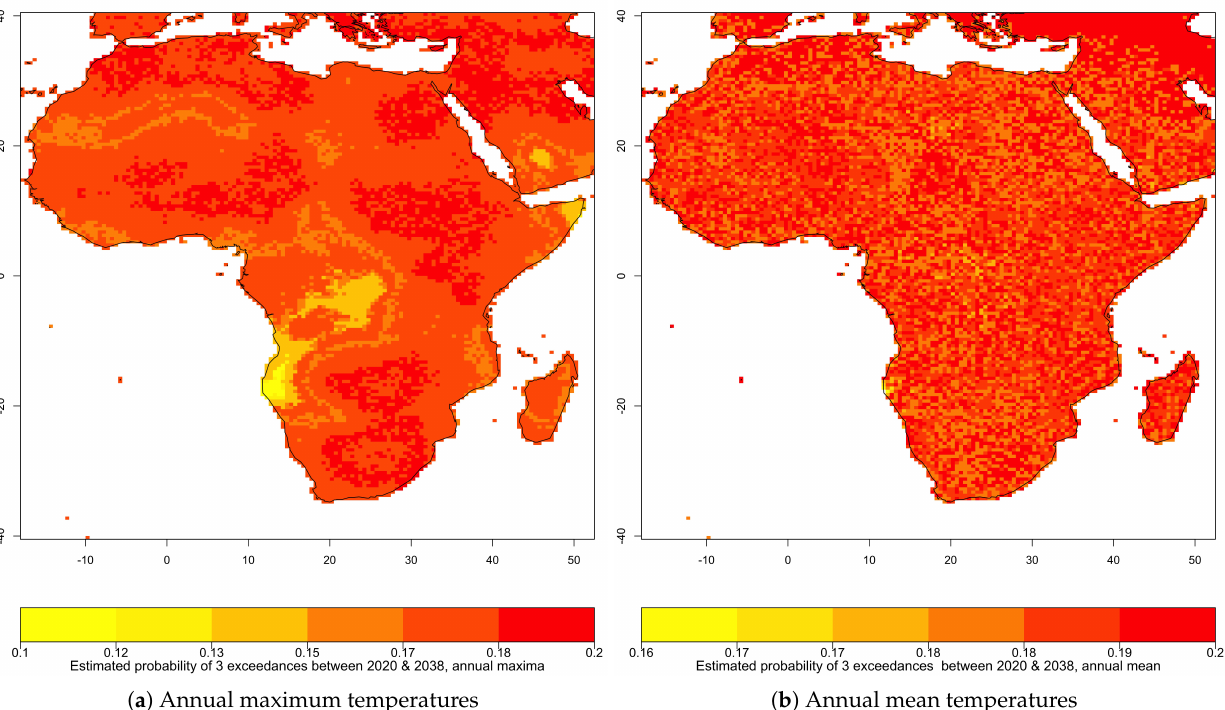
Figure 11. Estimated probability of three exceedances of the new threshold over the next 19 years period (2020 to 2038): ( a ) annual maximum temperatures and ( b ) annual mean